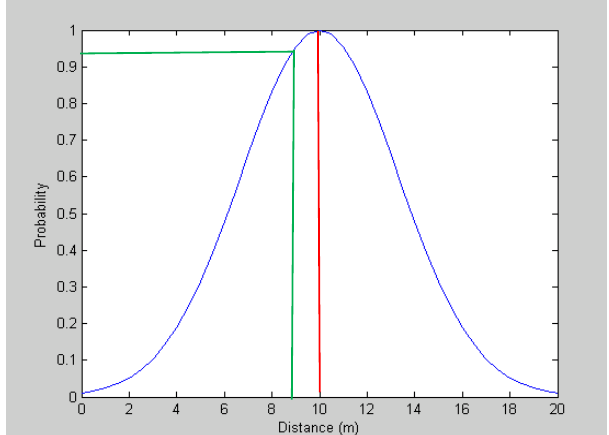
Figure 5. Likelihood function measuring the degree of closest between D and UD